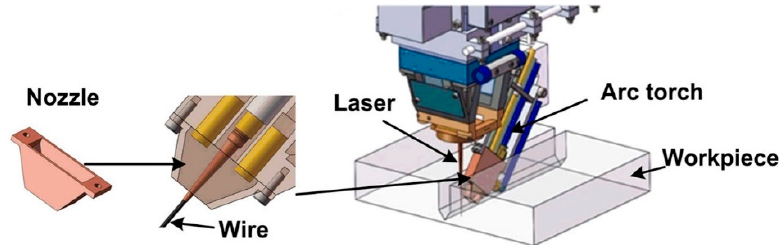
Figure 10. Three-dimensional diagram of laser-MIG hybrid welding process, with an example of the arrangement of a trapezoidal nozzle for the shielding gas. (Adapted from [75] with permission, Springer London, 2017).